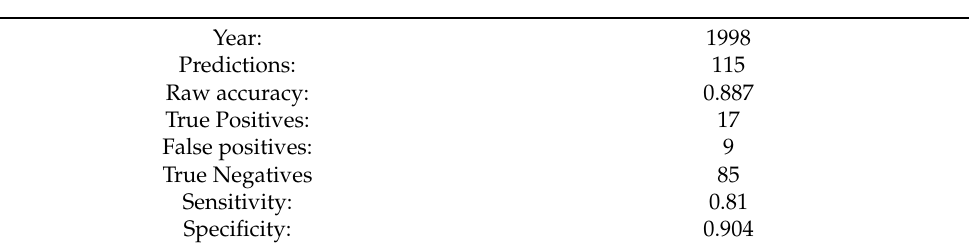
Table 8. ANN metrics for testing the same